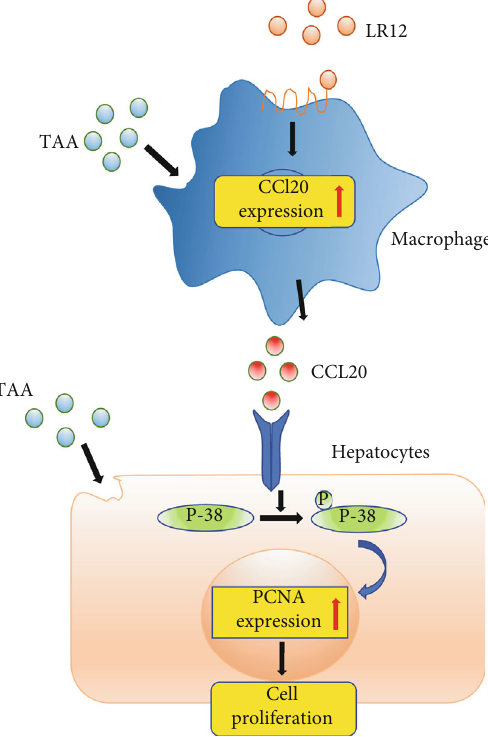
Figure 8: LR12 could promote regeneration of